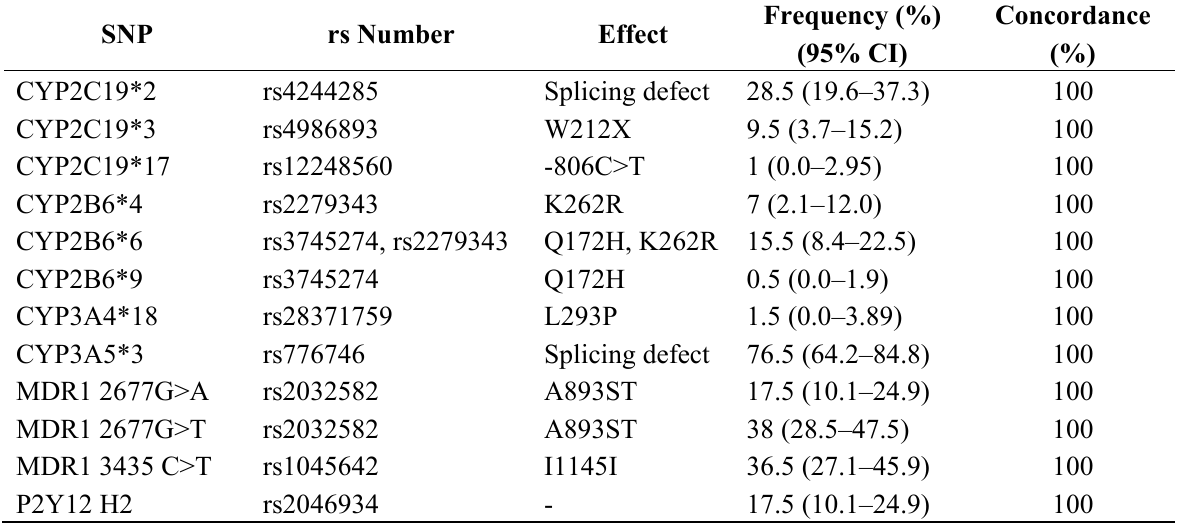
Table 3. Frequency and concordance of detected variants with DNA sequencing in a Korean population ( n =